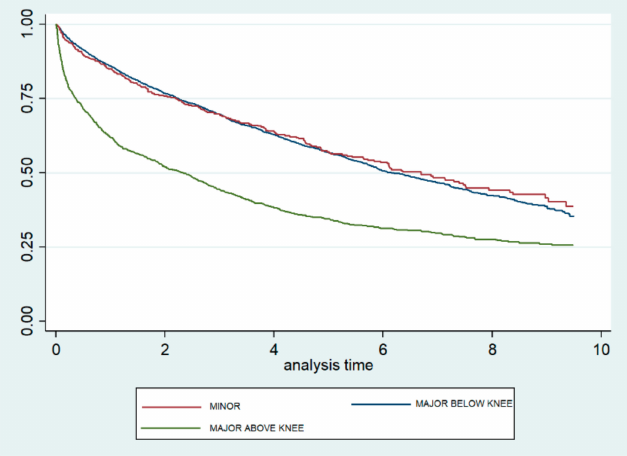
Figure 2. Kaplan–Meier survival curves, according to level of lower extremity amputation, among type 2 diabetic patients in the Autonomous Community of Madrid (Spain) from 2006 to